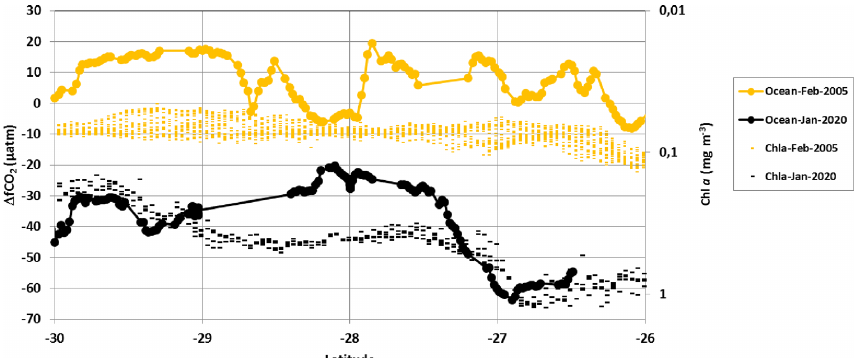
− f CO atm Figure 4. (cid:49)f CO 2 (µatm) ( (cid:49)f CO 2 = f CO oce ) and sea surface Chl a (mgm − 3 ) distribution in January 2020 (black) and February 2 2 2005 (orange) along the same track around 54 ◦ E in the south-western Indian Ocean. Here Chl a is in log 10 scale and inverted. In 2020 when the SEMB was particularly strong, (cid:49)f CO 2 was negative (ocean CO 2 sink), whereas in 2005 when the bloom was small, (cid:49)f CO 2 was close to 0 or positive (ocean CO 2 source).